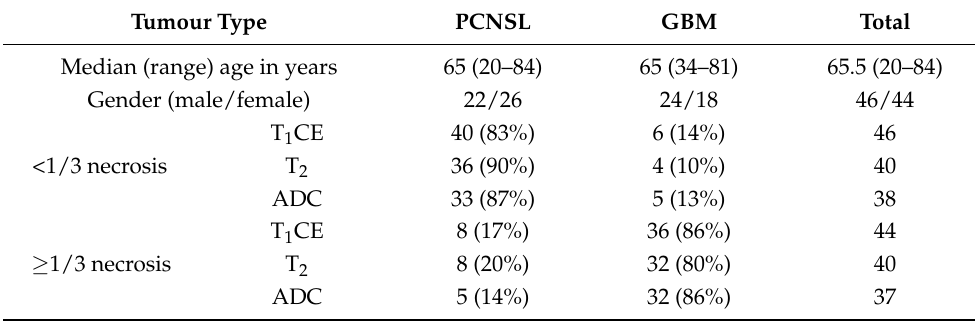
Table 1. Study population demographics and tumour